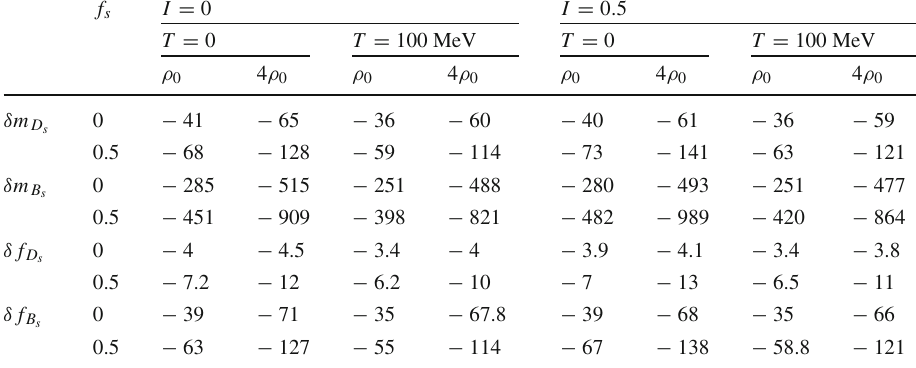
Fig. 2 Figure shows the variation of the shift in decay constants of pseudoscalar D s and B s mesons as a function of squared Borel mass parameter, M 2 for baryonic densities ρ 0 and 4 ρ 0 . The results are given